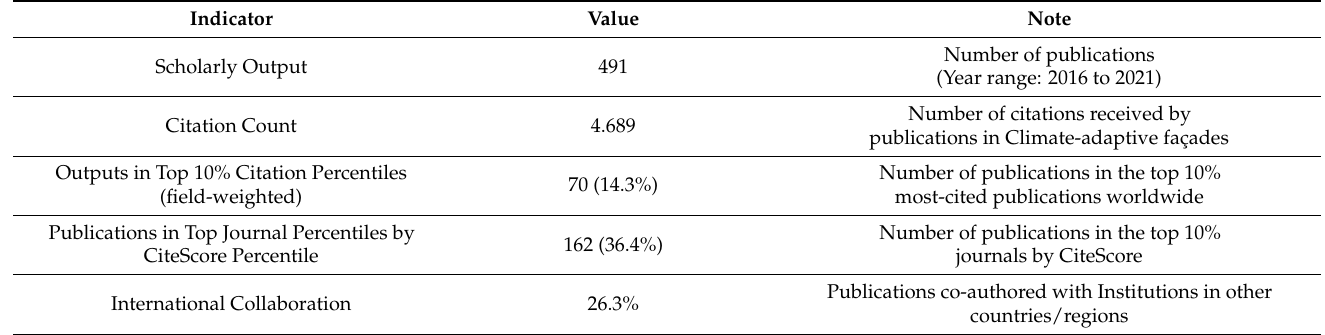
Table 3. Main indicators of the theme (accessed on 21 January 2022).